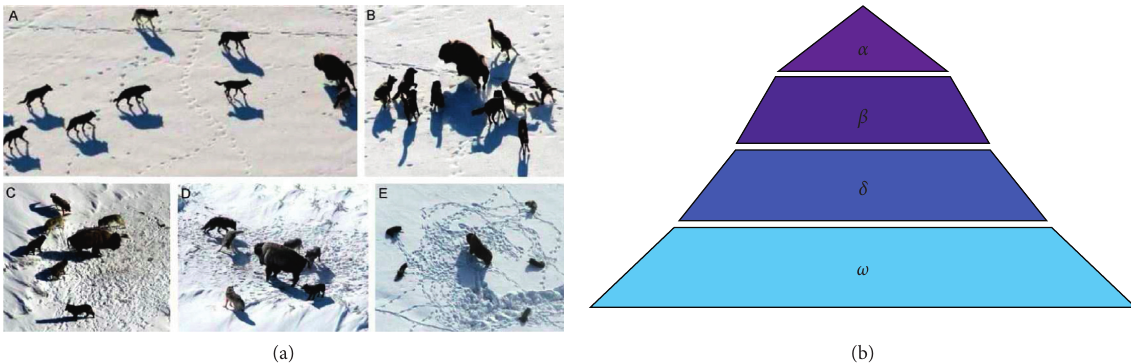
Figure 1: (a) Hunting behavior of grey wolves: (A) chasing, approaching, and tracking prey; (B–D) pursuing, harassing, and encircling; (E) stationary situation and attack. (b) Hierarchy of grey wolf (dominance decreases from top